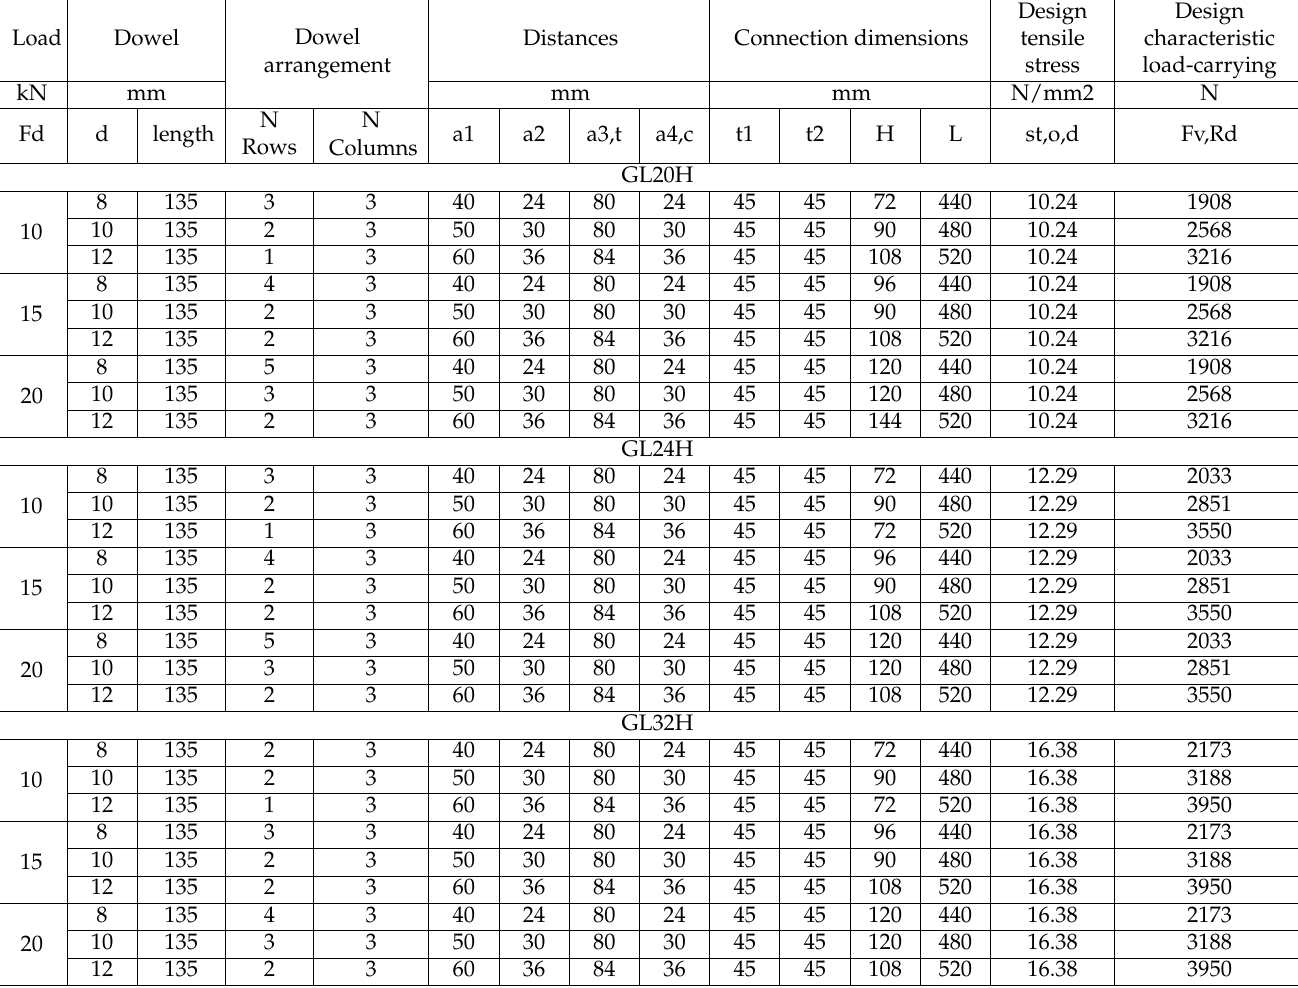
Table 3. Design parameters for W-W-W